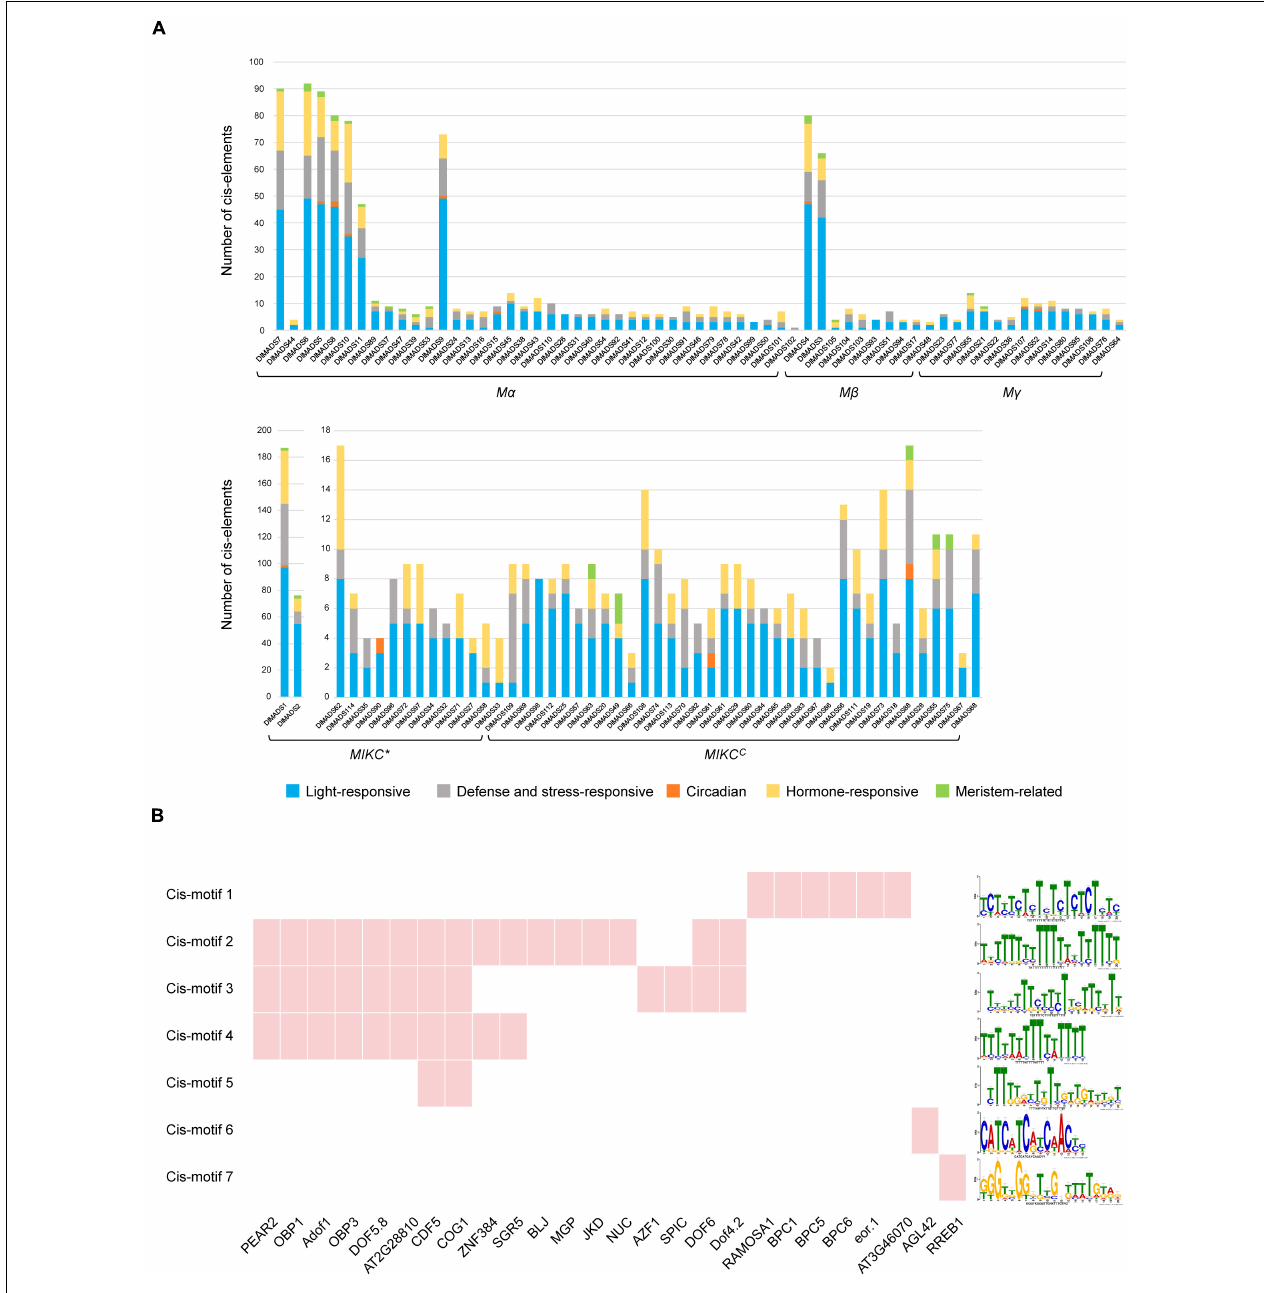
FIGURE 5 | Prediction of cis-elements and transcription factors of DlMADS . (A) The number of cis-elements related to light-responsive, defense and stress-responsive, circadian, hormone-responses and meristem. The upstream 1.5 kb sequences of all longan MADS-box genes were analyzed through PlantCARE. (B) The cis-motifs and transcription factors potentially target 36 MIKC C genes. Red indicates the transcription factor binding sites were found in promoter motifs of MIKC C genes.